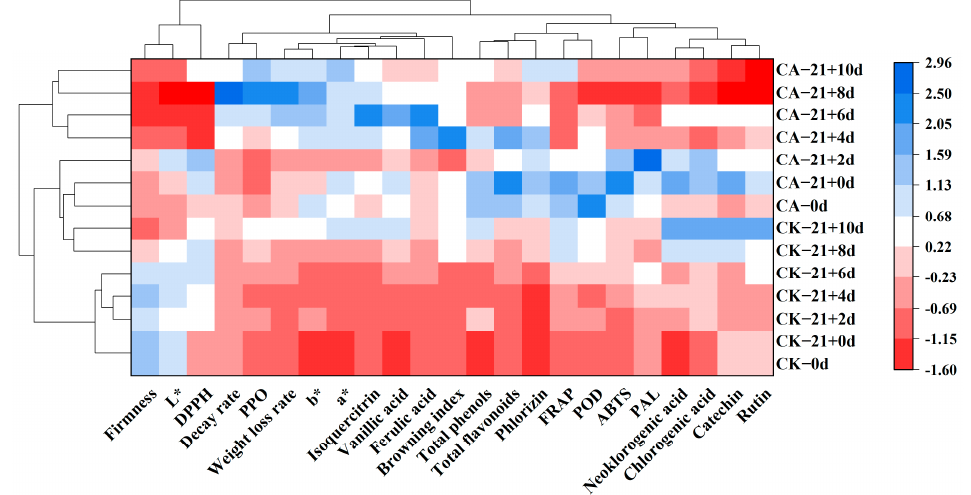
Figure 10. Heat map of hierarchical cluster analysis of yellow peach index parameters for different treatments, with three replicates for each treatment.